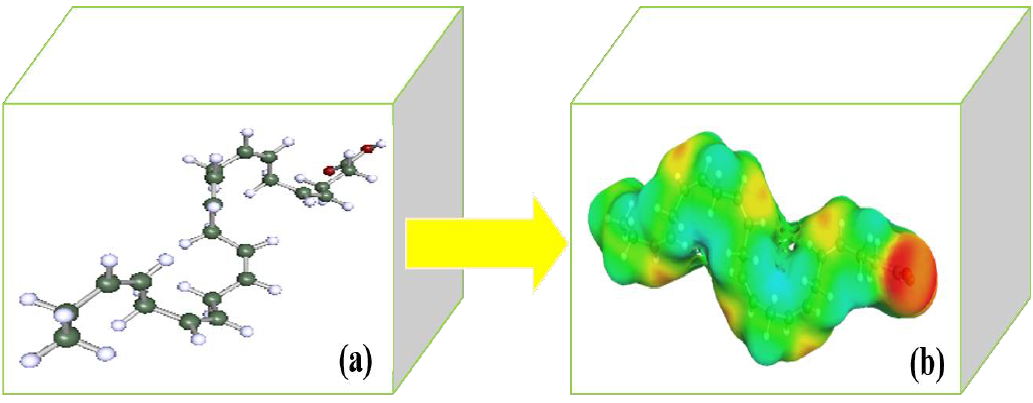
Figure 3. ( a ) Optimized molecular structure of DHA and ( b ) σ -surface of DHA compound performed by COSMOtherm.